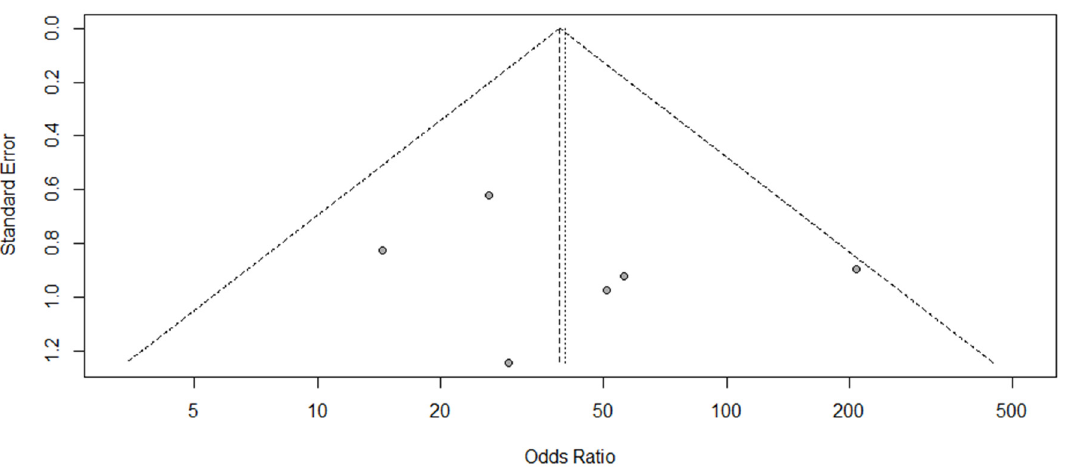
Figure 5. Funnel plot.